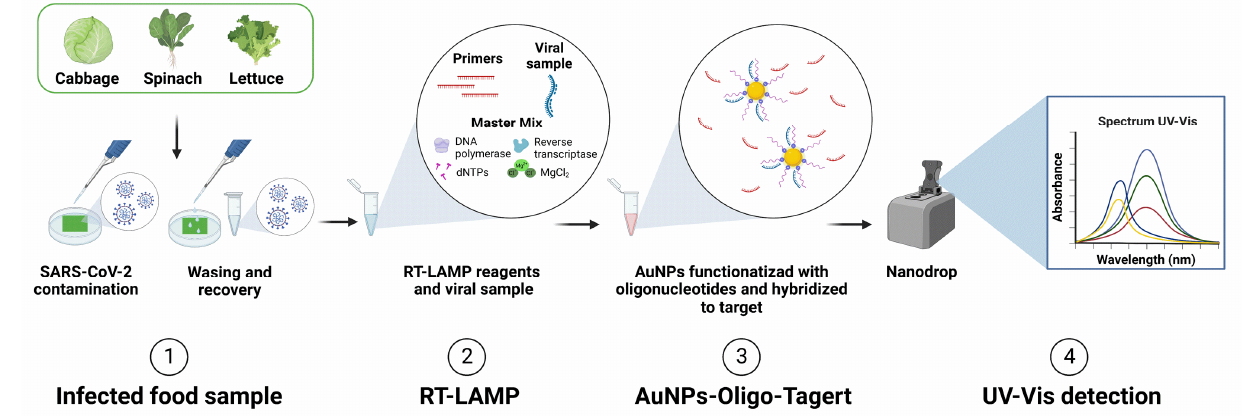
Figure 1. Schematic representation of the main stages of development and application of a nanobiosensor based on AuNPs functionalized with oligonucleotides for the detection of SARS-CoV-2 in food surfaces.